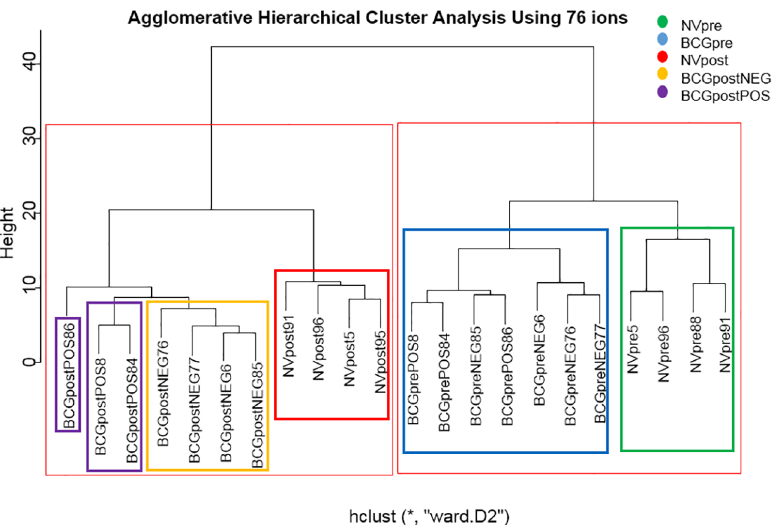
Fig 2. Agglomerative hierarchical cluster analysis constructed using 76 ions. Initial pairingof individuals of respectivesample groups is present. Progression through the hierarchyplaces paired individuals into respectivesample groups. The final separationplaces each individualits respectivepre- or post-challenge group. Clear separationof pre- and post-challenge sample groups is observed. Clear separation of NVpre and BCGpre individualsindicatesthat these animalsare distinctly different. All BCGpreNEG and BCGprePOS samples are within one cluster, indicating similarity prior to virulent M . bovis challenge. Post-challenge BCGpostNEG and BCGpostPOS samples within separate, but closely associated clusters, indicatesthat while difference among those individualsis present, they still are similar. All NVpostPOS individualsare found in a distinct cluster indicating a strong inter-group